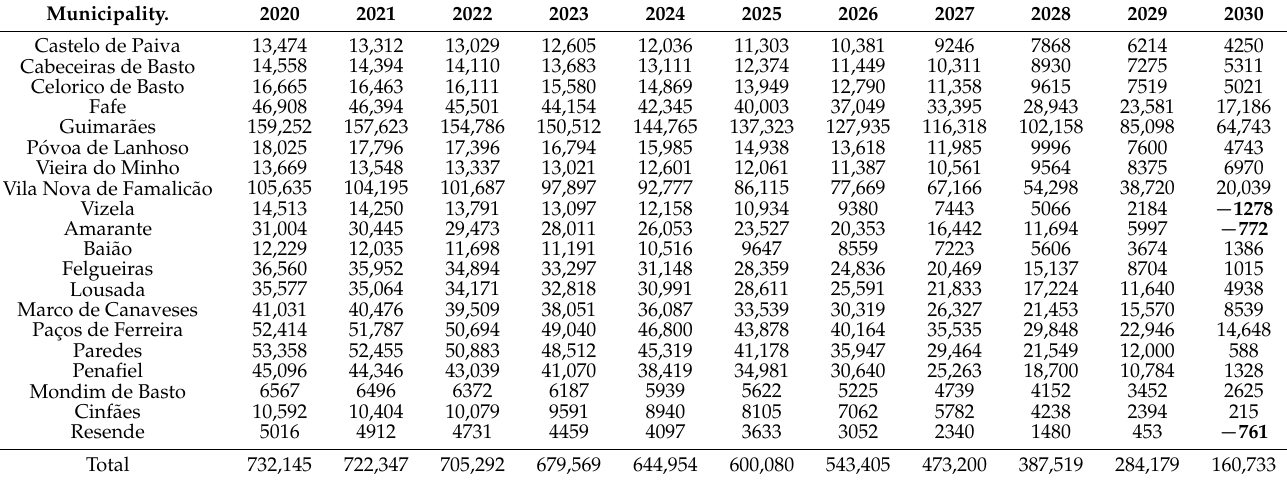
Table A2. Scenario 1: Impacts (available power–required power) of the BEV fleet on the grid during peak hours (values in